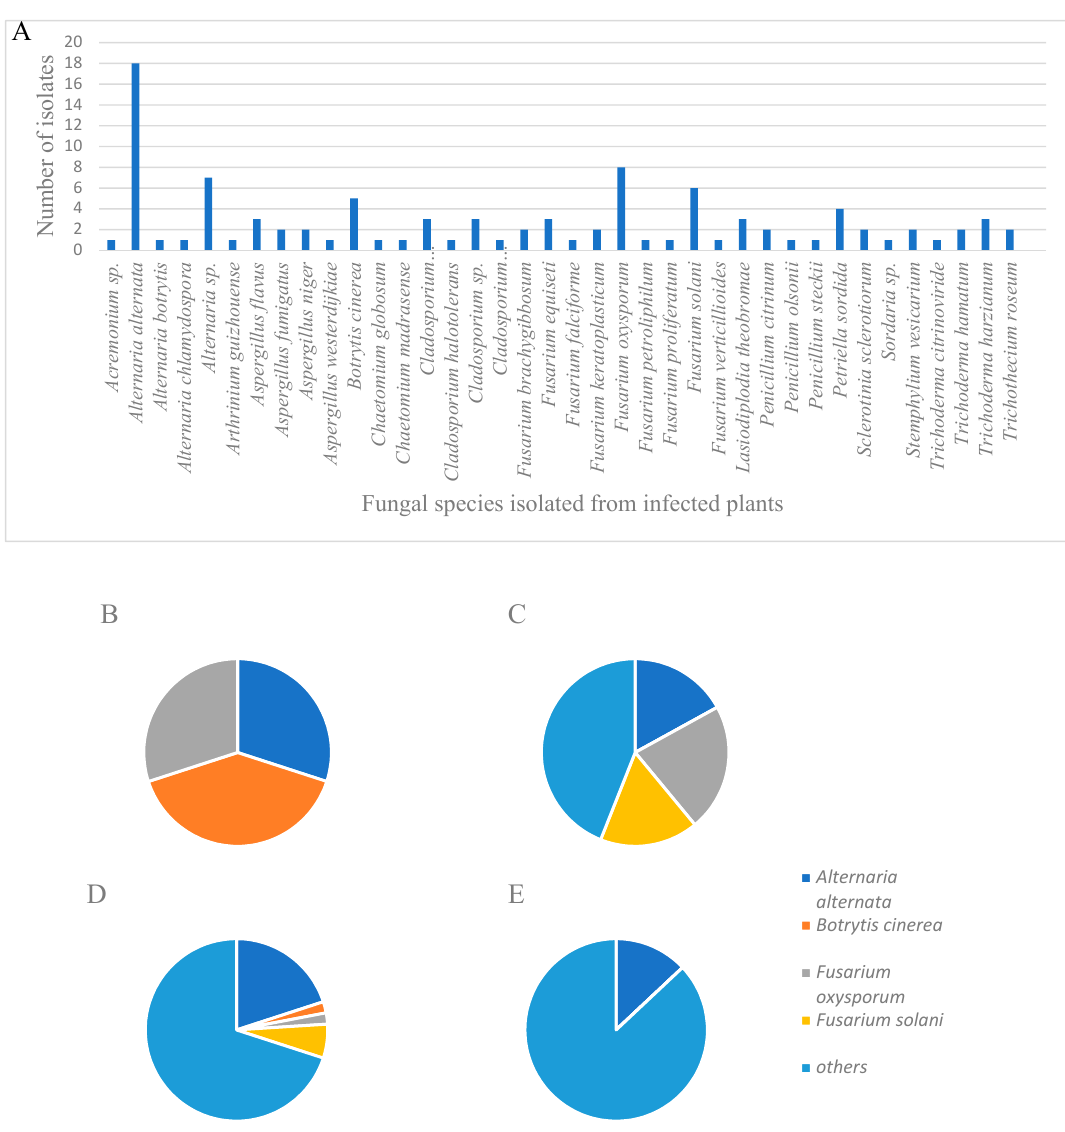
Figure 1. ( A ) Fungal species that were isolated from infected plant material from commercial farms throughout Israel. The four most frequent fungi that were isolated included Alternaria alternata , Botrytis cinerea, Fusarium oxysporum , and F. solani. ( B – E ) Pie charts of isolated fungi, with emphasis on the four most common fungi that were isolated ( Alternaria alternata, Botrytis cinerea, Fusarium oxysporum, F. solani and others) during different seasons: ( B ) spring (March–May), ( C ) summer (June–August), ( D ) autumn (September–November) and ( E ) winter (December–February).